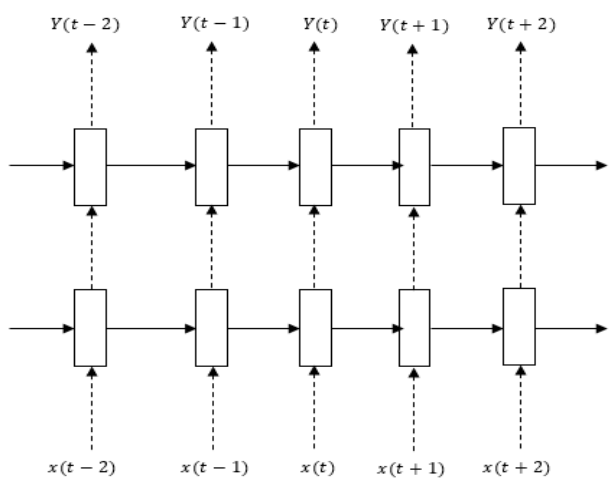
Figure 4. Dropout-based regularization.